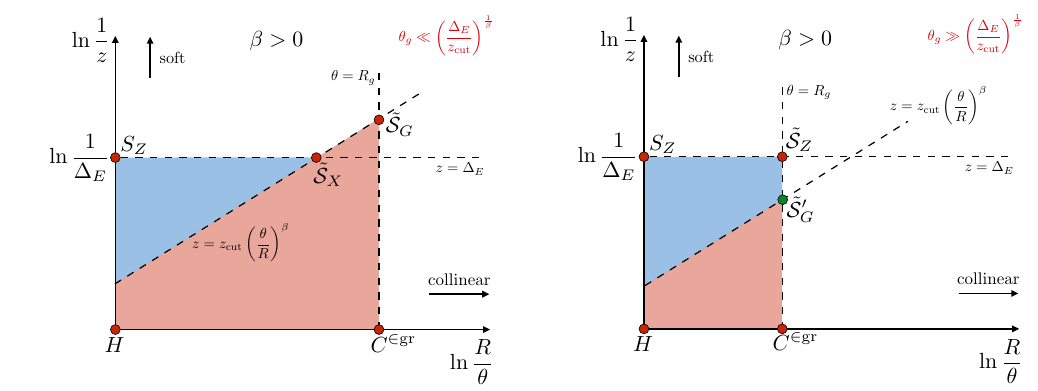
Figure 11 . Lund diagrams for the energy drop of a soft-drop groomed jet in the region ∆ E (cid:28) z cut (cid:28) 1 and θ g (cid:28) 1 , for regime A (left) and B (right). The relevant SCET modes are indicated by red and green dots, and their power counting can be read off, see table 3.